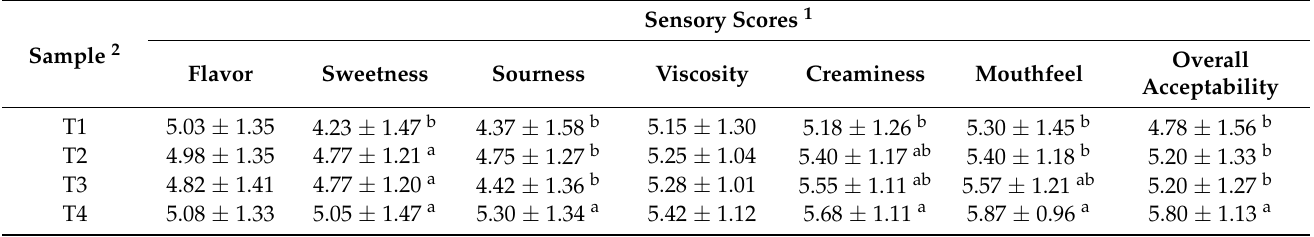
Table 3. Sensory scores of Greek yogurts with different starter cultures by Consumer preference